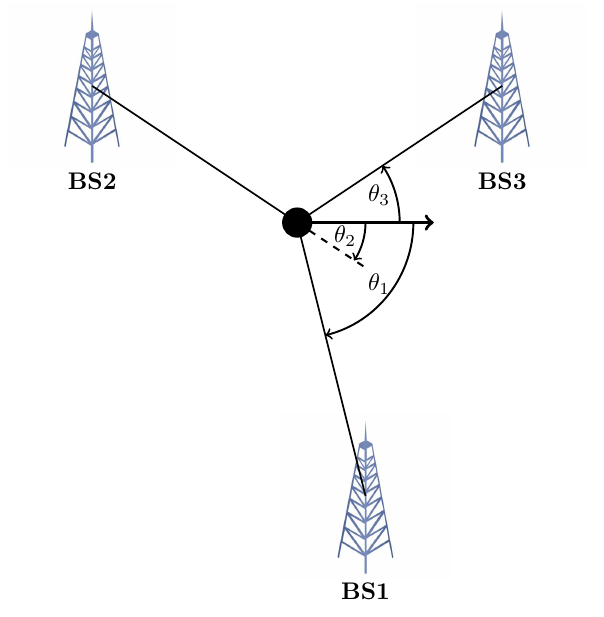
Figure 3. Triangulation: localisation based on AOA from 3